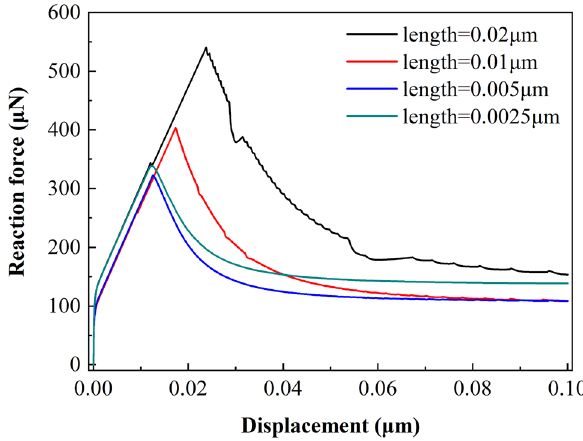
Figure 26. Displacement vs reaction force curves of cohesive elements with different characteristic length.